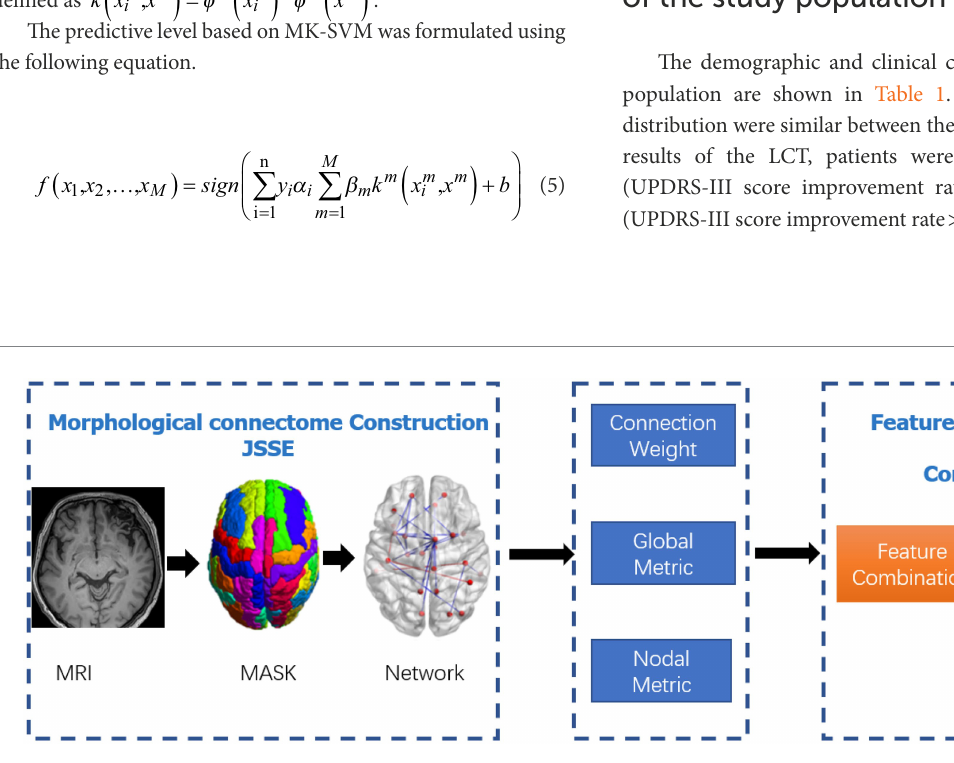
FIGURE 1 Data-processing and classification procedures adopted in the study. The JSSE was chosen to construct the morphological network. Then, the nodal and global graph metrics were computed. In the end,the MK-SVM was adopted to combine these information for